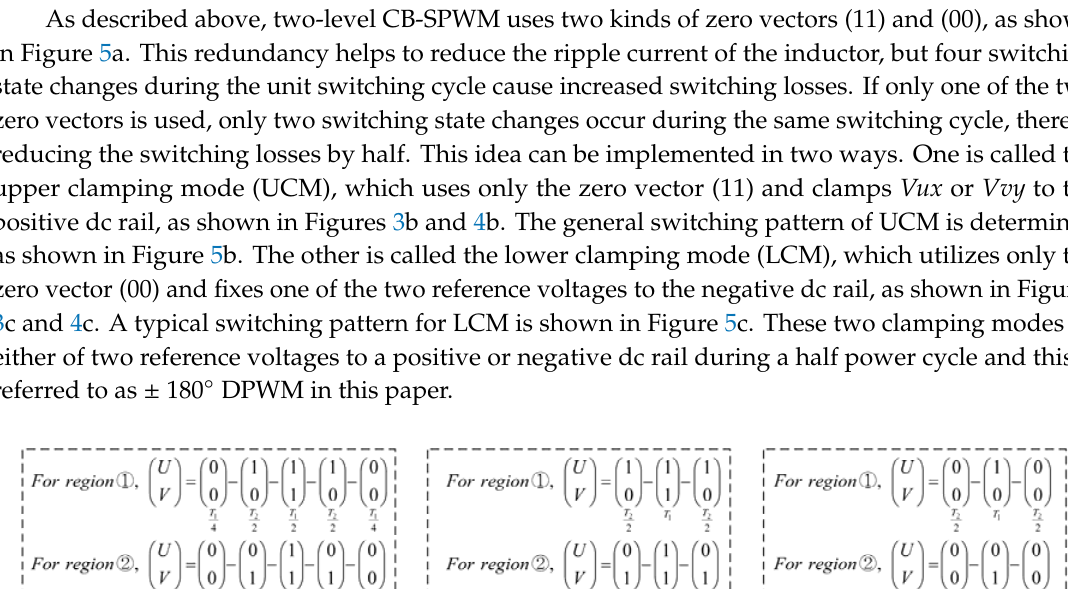
Figure 4. Typical switching sequence according to the PWM methods: ( a ) conventional CB-SPWM, ( b ) proposed DPWM with UCM, and ( c ) proposed DPWM with LCM. 3. Proposed Discontinuous Pulse ‐ Width Modulation (DPWM) for Single ‐ Phase PWM Converter